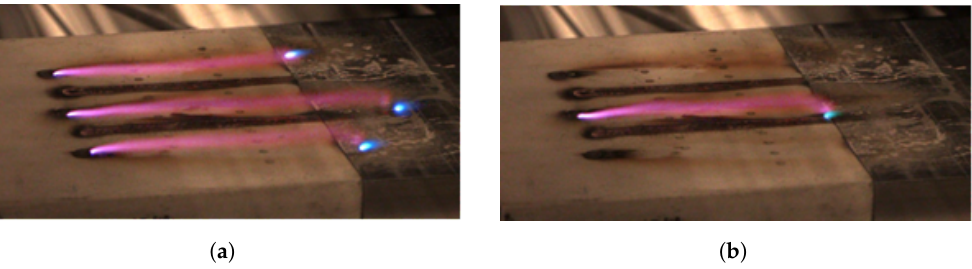
Figure 4. High speed image of plasma filaments an exposure time of 4 µ s for ( a ) triple plasma filaments vs. (b) single filament. Flow is from left to right.